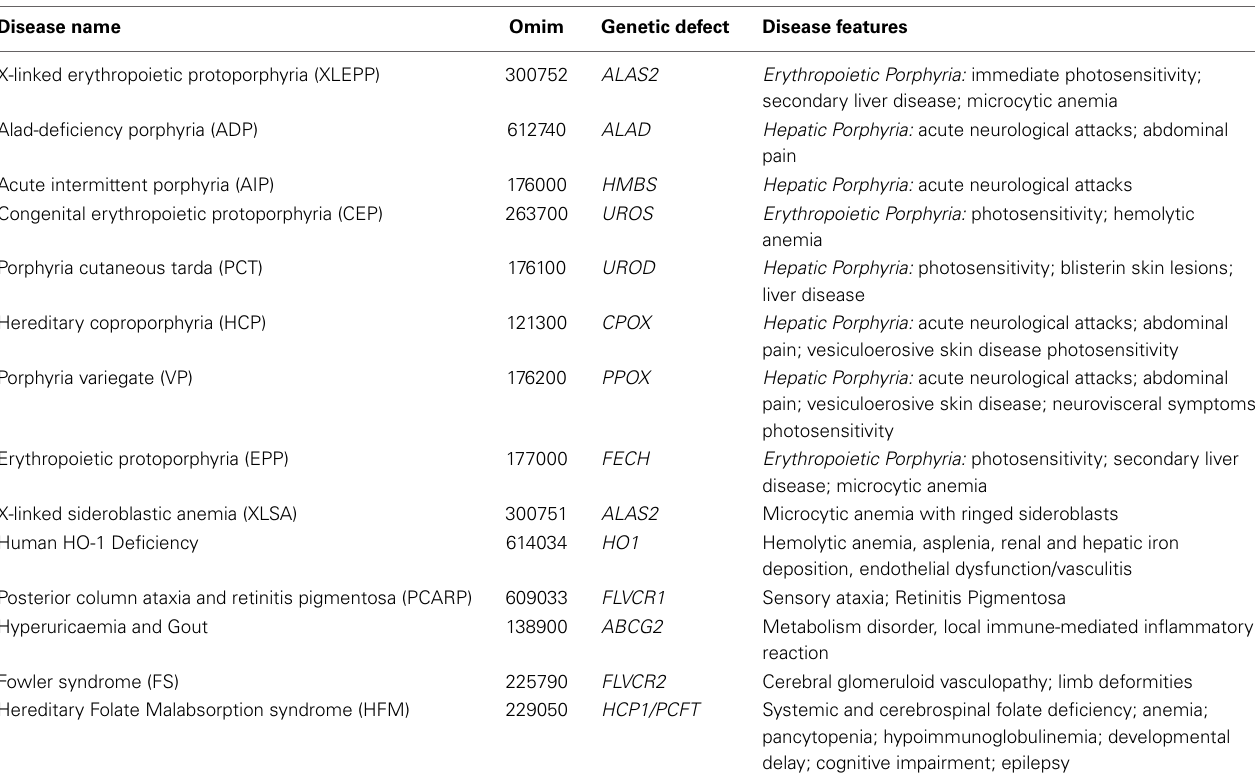
Table 2 | Disorders associated to mutations in genes involved in heme